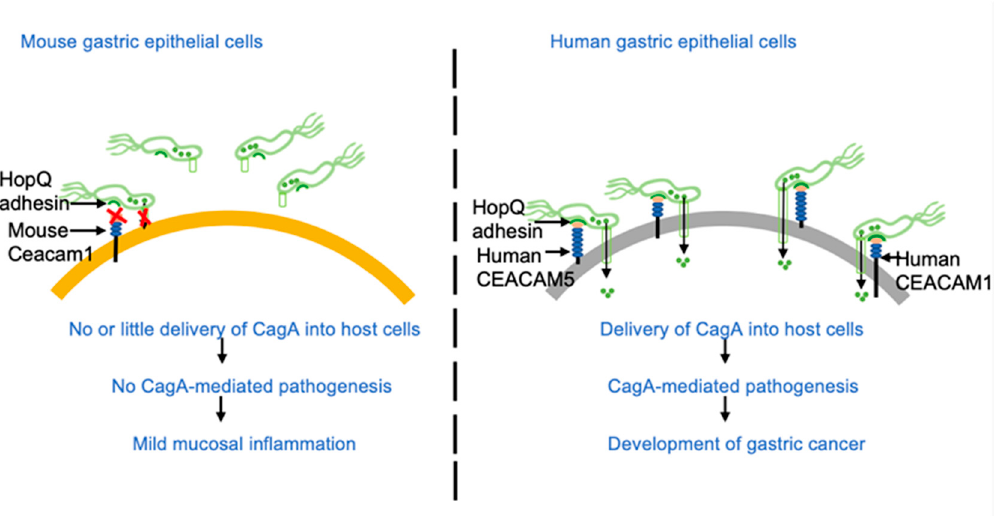
Figure 8. Schematic representation of H. pylori infection in mouse and human gastric epithelial cells. Due to low expres- sion of mouse Ceacam1 followed by the incompatible interaction between mouse Ceacam1 and H. pylori HopQ, there is no or little delivery of CagA in the mouse gastric epithelial cells. In contrast, compatible binding of H. pylori HopQ to expressed human CEACAMs leads to efficient delivery of CagA in human gastric epithelial cells leading to CagA medi- ated